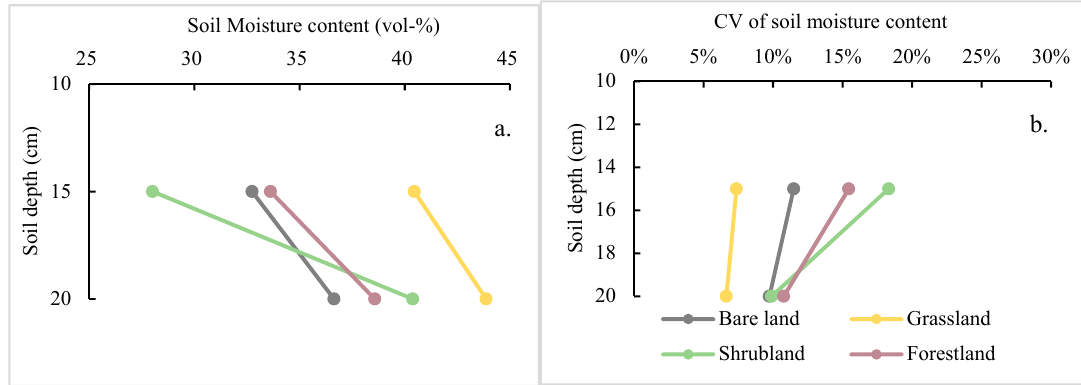
Figure 3. Average value ( a ) and CV ( b ) of volumetric soil moisture content at different soil depths.